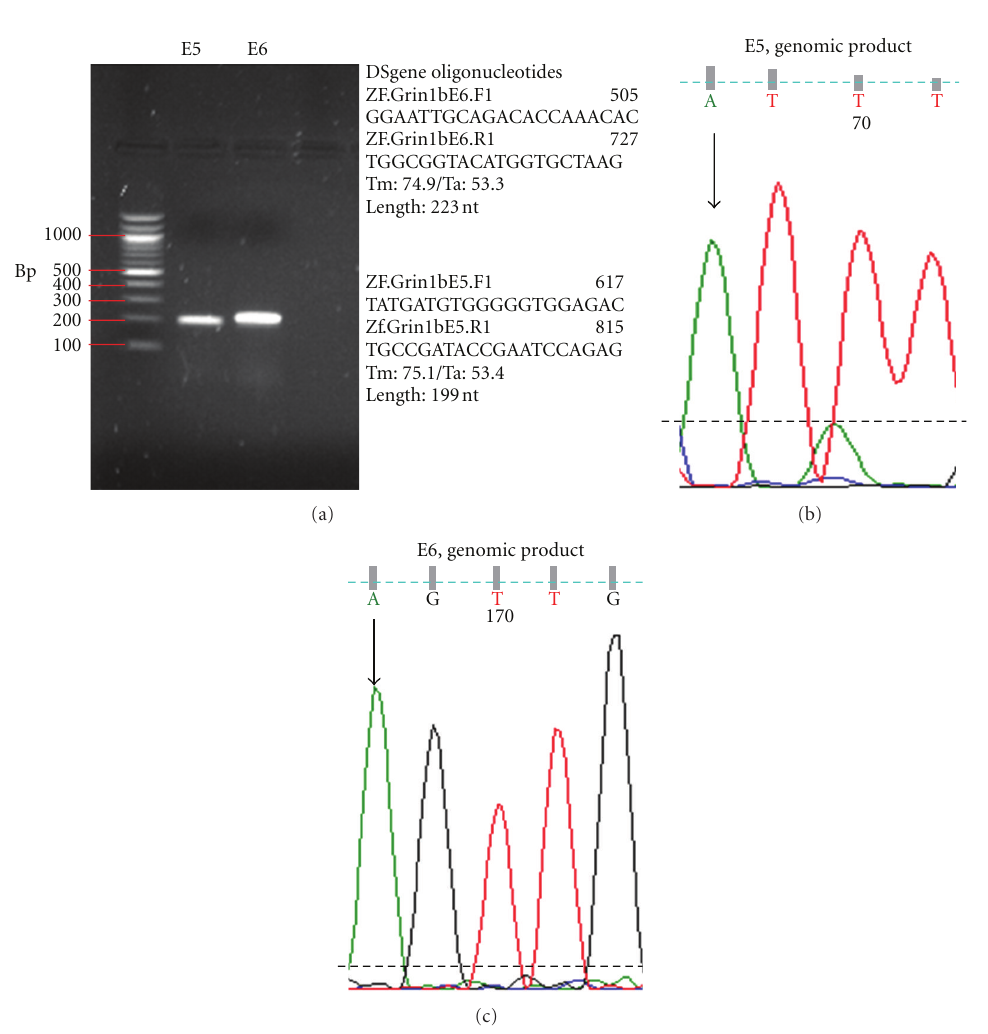
Figure 5: Genomic products; E5, E6. PCR amplification of regions within the grin1b gene corresponding to E5 and E6 potential RNA editing sites. As predicted by the DS Gene computer program (Accelrys), primers designed to target the genomic E5 sequence (ZF.Grin1bE5.F1 and ZF.Grin1bE5.R1) produced a strong band at around 200 nucleotides. Primers aimed at amplifying the genomic E6 sequence (ZF.Grin1bE6.F1 and ZF.Grin1bE6.R1) produced a strong band at around 220 nucleotides. Both of these bands were extracted for sequencing reactions. Amplicons from genomic DNA show no evidence of A/G polymorphism (A only). Dashed black lines represent noise levels per